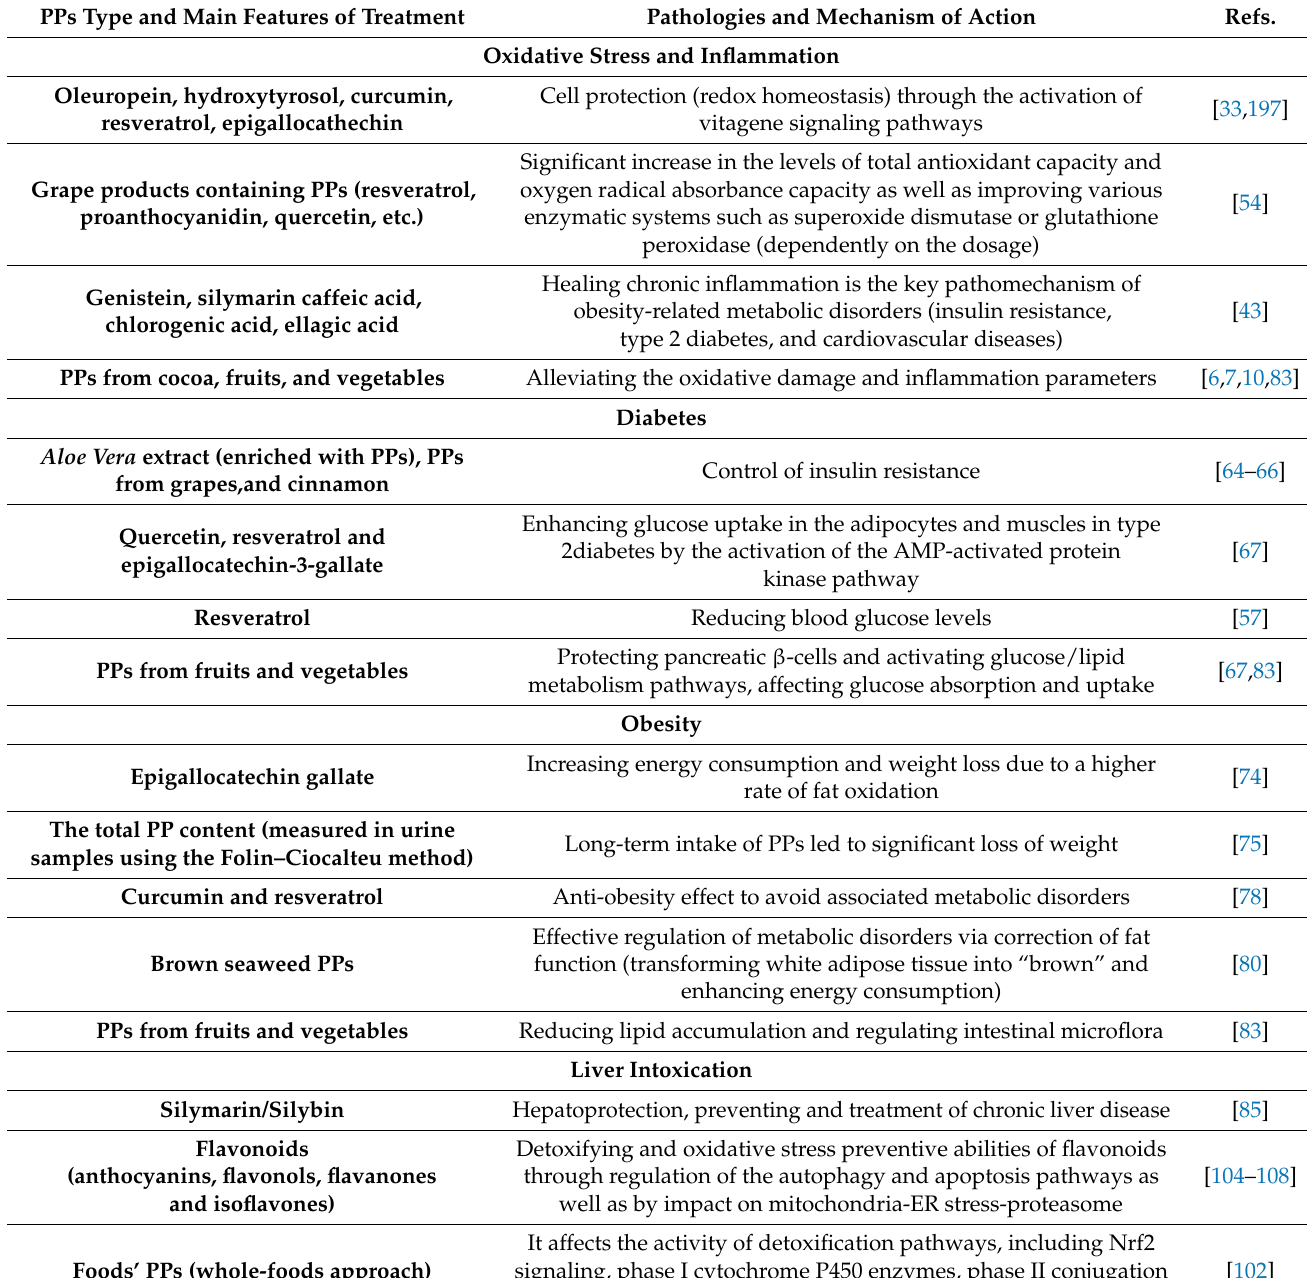
Table 1. The current state of the Mts treatments with polyphenols from clinical